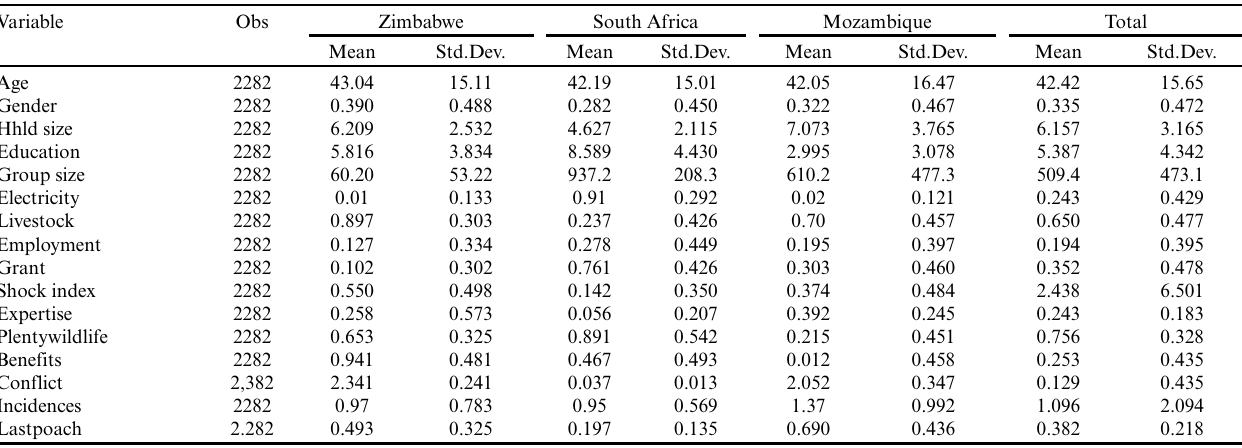
Table 4 . Descriptive statistics.